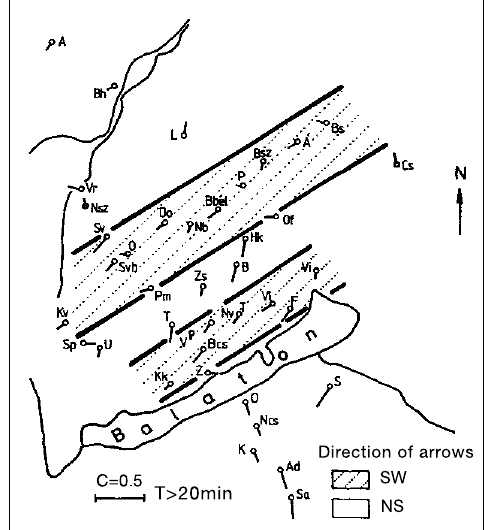
Fig. 2. Long period ( T > 20 min) Wiese induction arrows in the area of the Transdanubian Conductivity Anomaly measured by GGRI (Wallner,